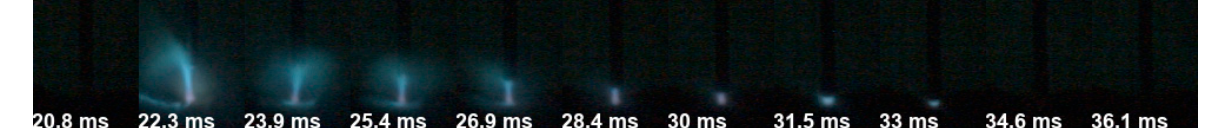
Figure 1. Three definitive CMT cycles. Figure 2. CMT cycle, time correlates with the waveforms in Figure 1.